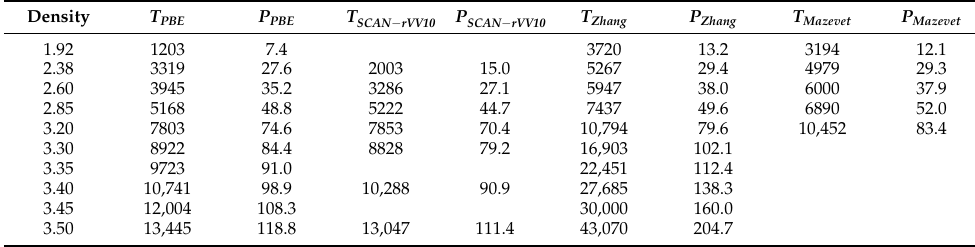
Figure 1. The Hugoniot curve of liquid nitric oxide (( a ): pressure as a function of density, ( b ): pressure as a function of temperature, ( c ): pressure as a function of compression ratio, ( d ): temperature as function of density). The present calculation: magenta solid line with sphere for PBE functional and red solid line with star for SCAN − rVV10 functional both from the initial state at 1.263 g cm − 3 and 122 K, compared with quantum molecular dynamics simulations (blue solid line with square for PBE functional of Zhang et al. from initial state at 0.807 g cm − 3 and 122 K [24] and green solid line with triangle for PW91 functional of Mazevet et al. from initial state at 1.22 g cm − 3 [26]) and experiment of Schott et al. (black diamond) [33]. Table 1. The present Hugoniot EOS compared with the results of Zhang et al. [24] and Mazevet et al. [26]; the density unit is g cm − 3 , all temperature units are K, and all the pressure units are GPa.